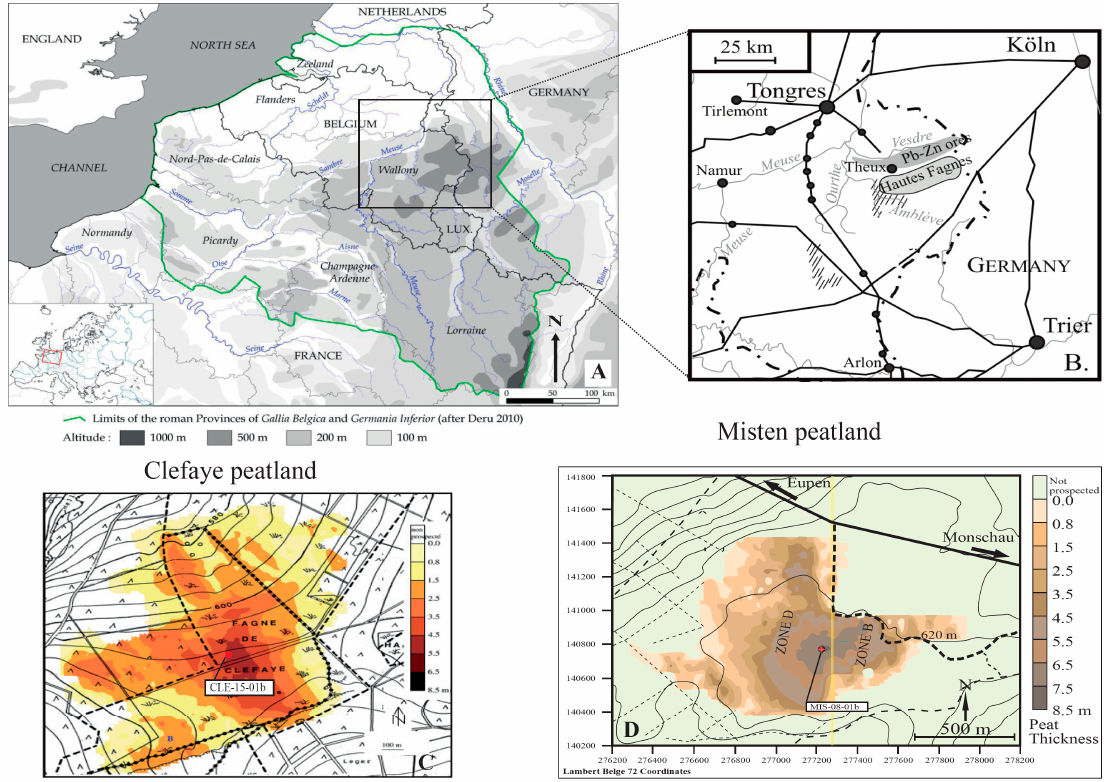
Figure 1. ( A ) Localisation of Belgium as a part of Gallia Belgica (northern France, western Germany, southern Netherlands and Belgium) (after Deru [56]), ( B ) Location map of the Hautes Fagnes Plateau and the Pb-Zn ores of E-Belgium (modified from De Vleeschouwer et al. [43]), ( C , D ) Radar derived peat thickness of the Clefaye and Misten bogs (modified after Wastiaux and Schumacker [55]). Coring location is reported by the red circle.